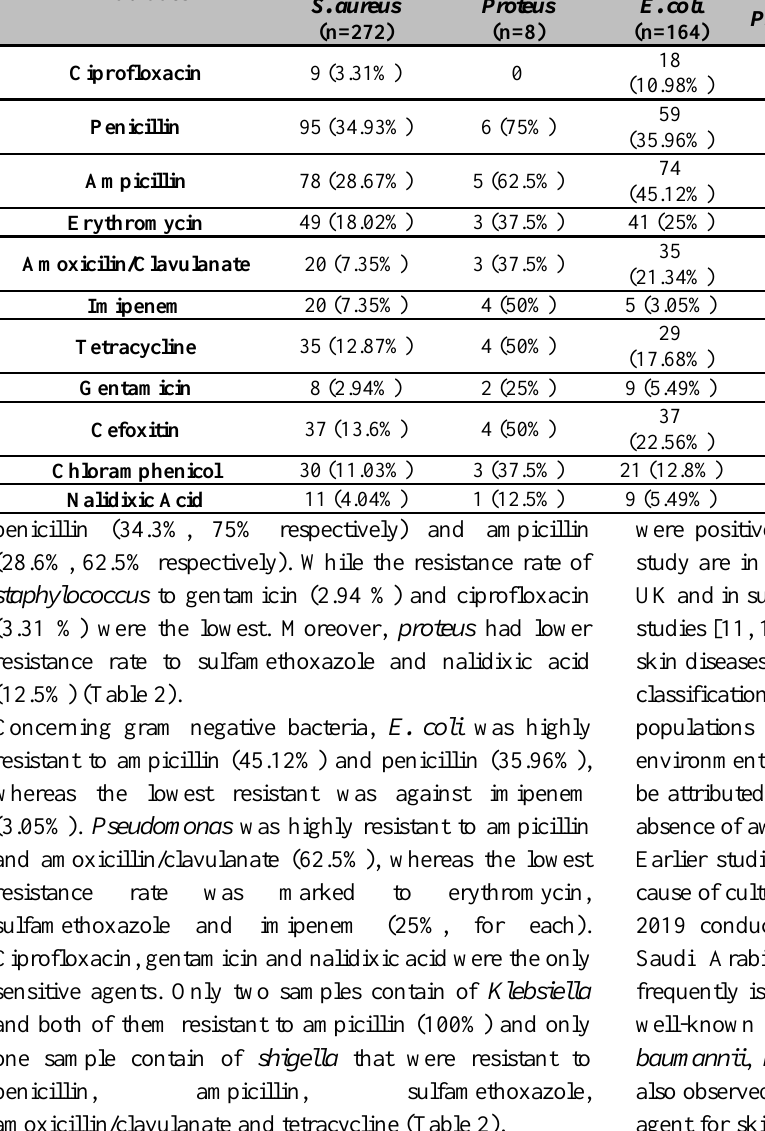
Table 2. Resistance pattern of the isolated bacteria to tested antibiotics